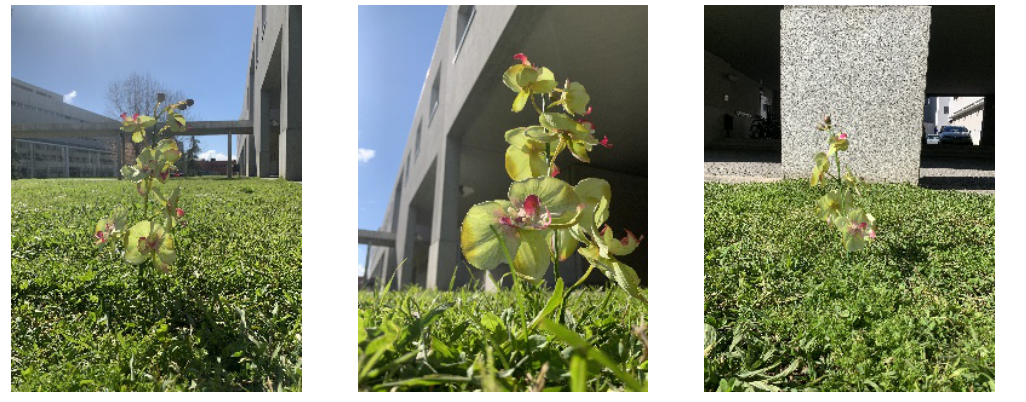
Figure 5. Sample resized images from the dataset.